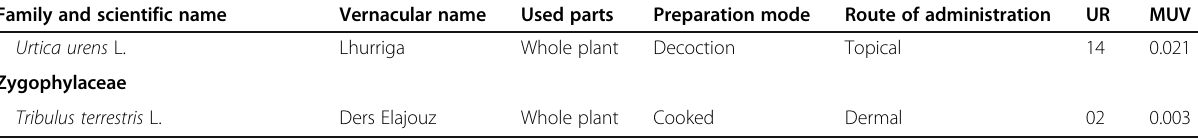
Table 2 Catalog of medicinal plants used to treat cystitis problems in the Rif, Morocco